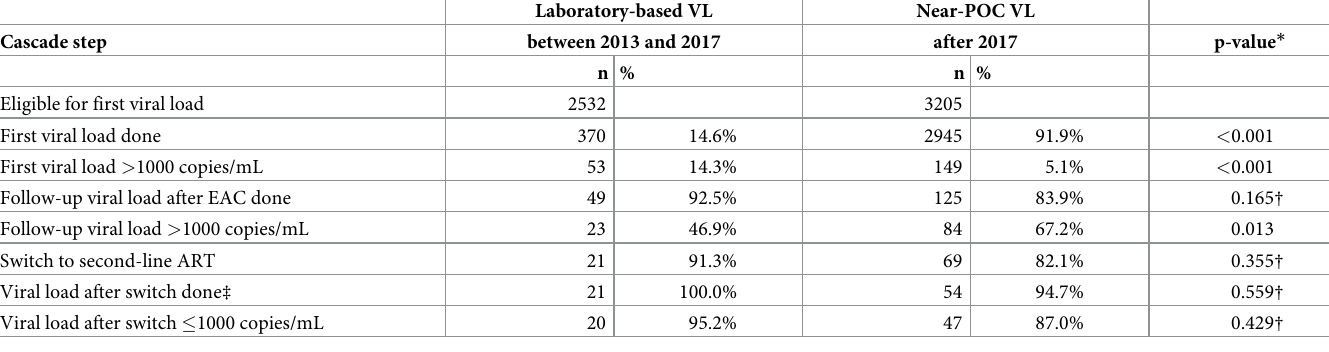
Table 2. Comparison of cascade after a first high VL before and after near POC VL testing was implemented. Laboratory-based